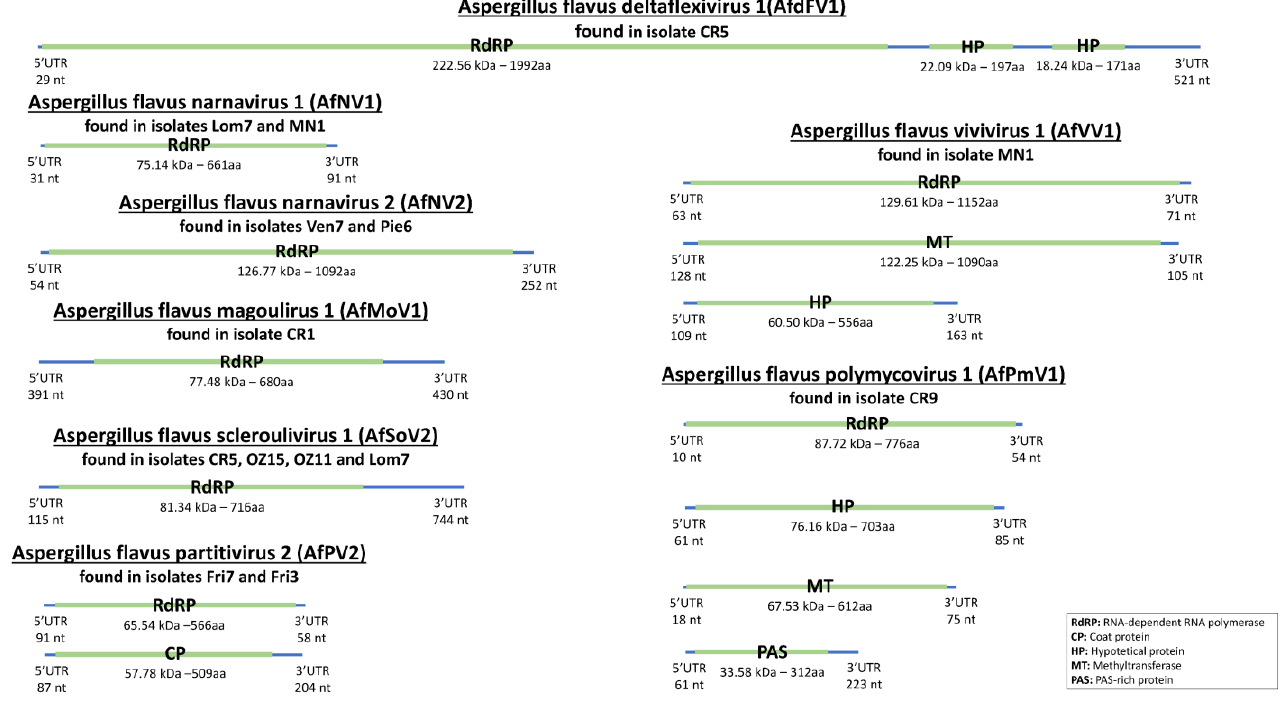
Figure 1. Representation of the genome organization of viruses identified in the present study. In blue are depicted the non-coding segments of genomes, whereas green portions represent the detected ORFs. Table 3. Summary of the new viruses detected in the present work: first hit in NCBI and putative function are reported for each genome segment, whereas genome type, viral group, and a putative name are reported for each new viral specie. First Hit in NCBI Identity